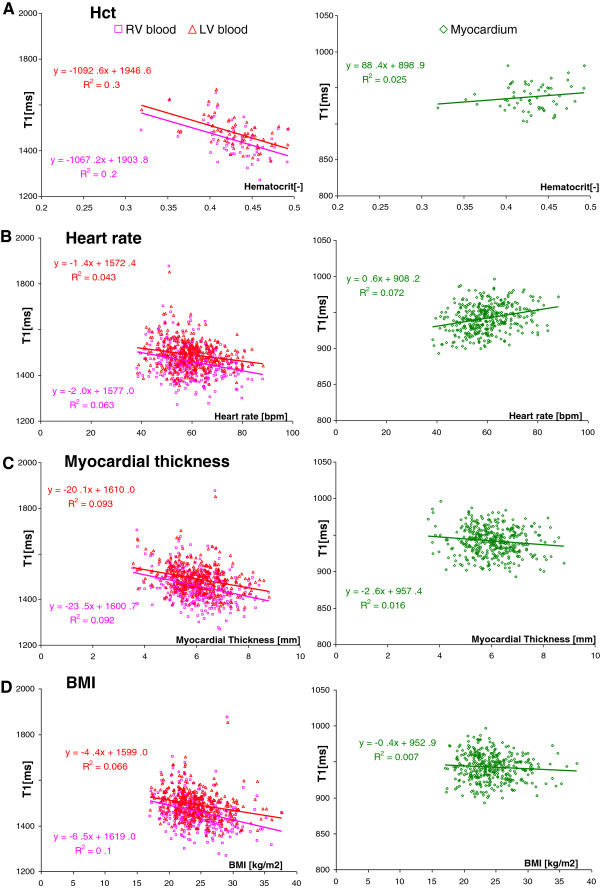
The effects of common physiological parameters on the myocardial midwall T1 and blood T1 after correcting for age and gender differences. (A) Blood hematocrit is the principle driving force of blood T1s, but not myocardial T1, variation. (B) Increase in heart rate is associated with an increase in myocardial T1 and a decrease in blood T1s. (C) There is no relation between myocardial thickness and myocardial T1, but blood T1s change in opposite direction. (D) Increased body size does not influence myocardial T1, but decreases blood T1s. Note: statistical significance of marked correlations reaches Bonferroni-corrected significance of p < 0.002 (p < 0.05/18 comparisons including height and weight not shown here) for r2 > 0.15 (n = 62, A) and r2 > 0.026 (n = 374, B-D).